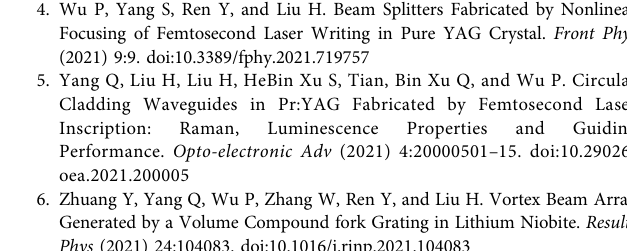
Frontiers in Physics |